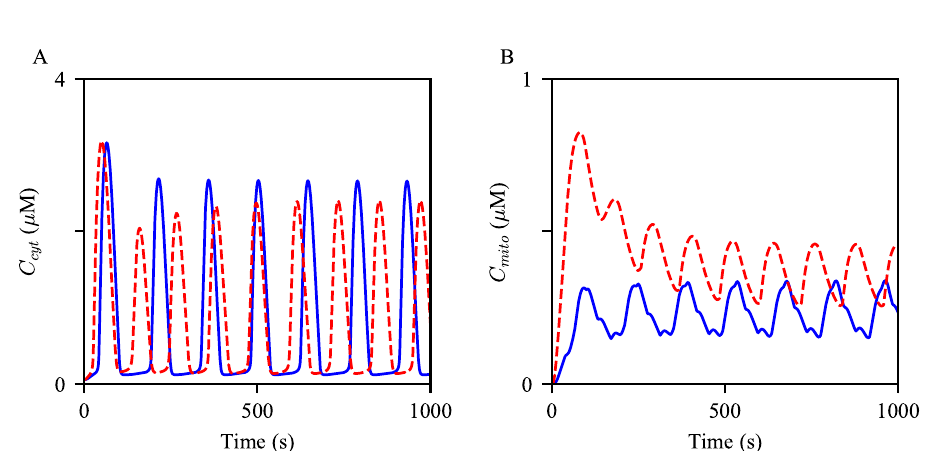
Fig 8. Effects of the cellular changes associated obesity on Ca 2+ oscillations. Oscillations of (A) cytosolic and (B) mitochondrial Ca 2+ concentrations generated from the model with different parameter sets. The blue oscillations were generated from the model with the control parameters. The red dashed oscillations were generated with the modified parameters as in Table 2. The model was given continuous stimulation of IP 3 with P s = 0.3 μ M.